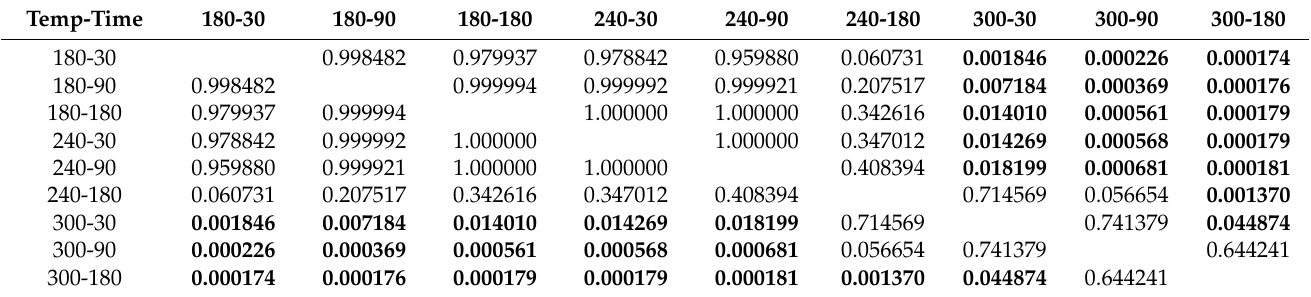
Table A9. Two-way analysis of variance (ANOVA) with post hoc Tukey test for Eg , a bold font signifies a statistically significant difference ( p < 0.05).